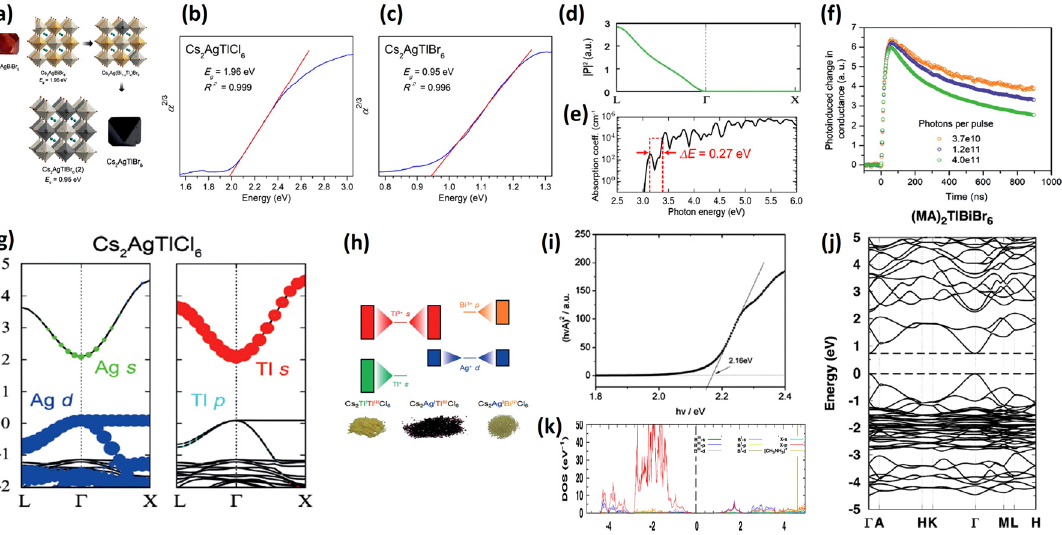
Figure 5: (a) Single-crystal structures of Cs 2 AgBiBr 6 and Cs 2 AgTlBr 6 double perovskites [110]. 2018 Wiley ‐ VCH Verlag GmbH & Co. KGaA, Weinheim. Tauc plot of (b) Cs 2 AgTlCl 6 and (c) Cs 2 AgTlBr 6 double perovskites [110]. 2018 Wiley ‐ VCH Verlag GmbH & Co. KGaA, Weinheim. (d) Transition dipole matrix elements | P | 2 along high-symmetry lines in reciprocal space. (e) Calculated absorption spectrum of Cs 2 AgTlCl 6 showingthe width of the symmetry forbidden region. (f) Time-resolved microwaveconductivity traces of Cs 2 AgTlCl 6 crystals [110]. 2018 Wiley ‐ VCH Verlag GmbH & Co. KGaA, Weinheim. (g) Calculated band structure of Cs 2 AgTlCl 6 [110]. 2018 Wiley ‐ VCH Verlag GmbH & Co.